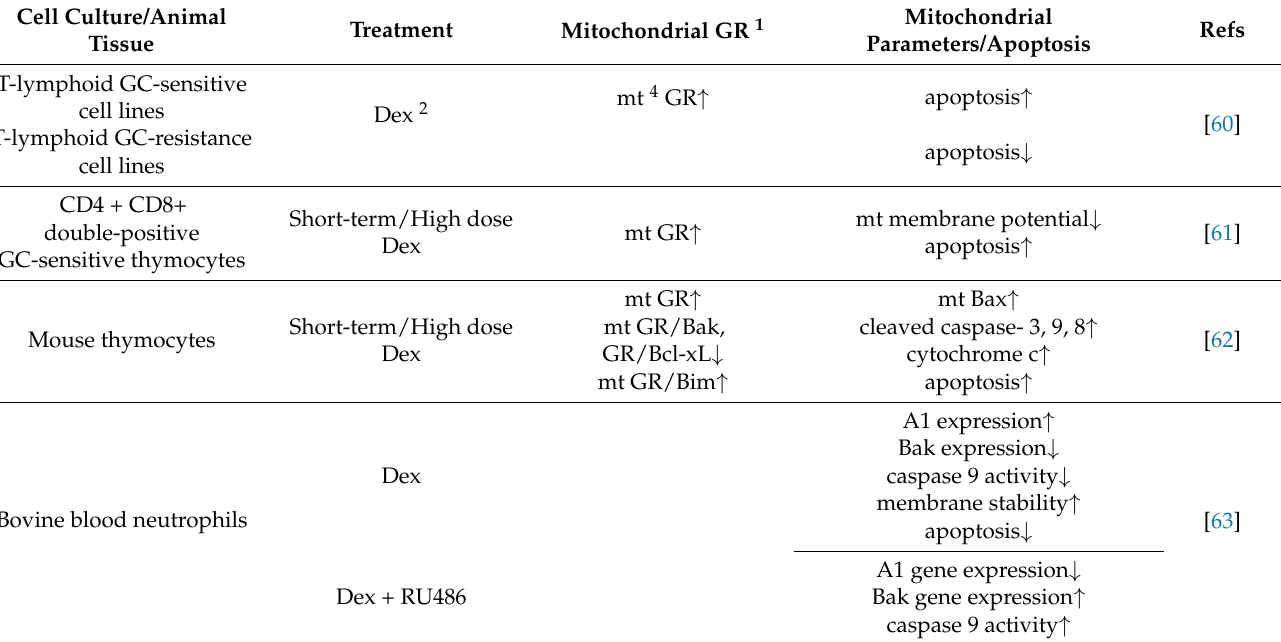
Table 2. Mitochondrial GR and apoptosis-associated